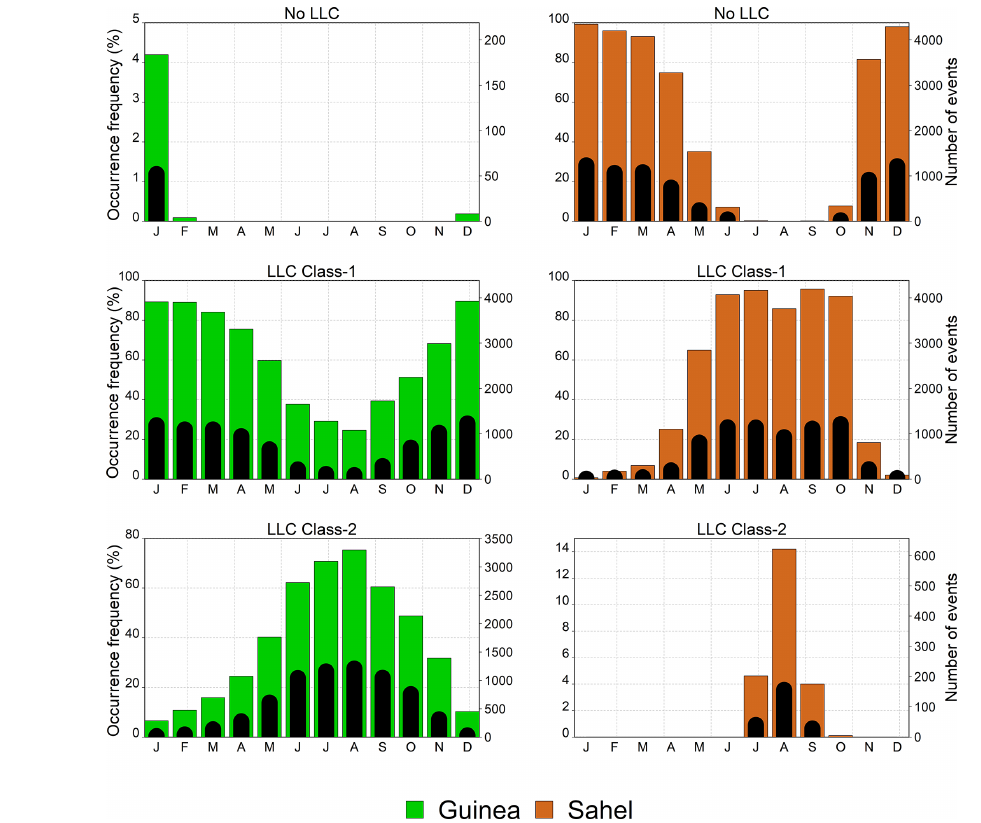
Figure 3. Monthly distribution of the occurrence frequency of hourly events for the three daytime LLC classes during the daytime in the Guinea (green bar) and Sahel (orange bar) regions defined in Fig. 1. The shorter black bars are the distribution of occurrences that last for at least 6 consecutive hours (the actual value has been multiplied by a factor of 4 to improve the legibility of the